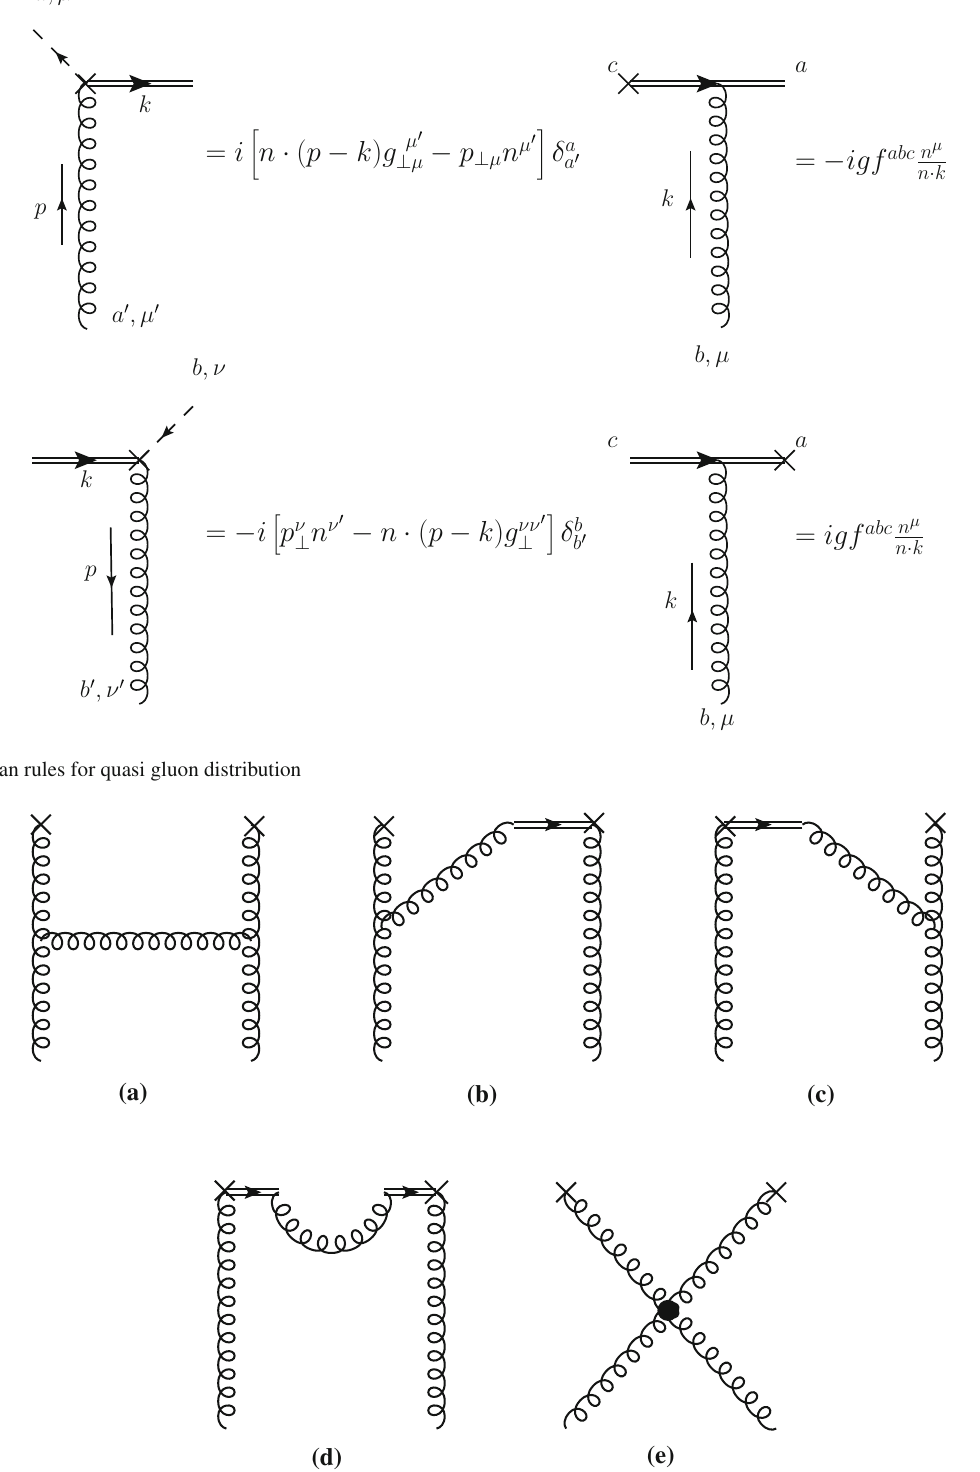
Fig. 2 One-loop real corrections to quasi (light-cone) gluon distribution in Feynman gauge. The double line includes both the gauge link and non-abelian